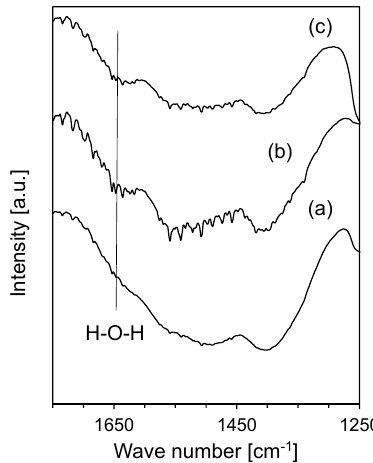
Figure 5. FTIR spectra of F04M catalyst coated with silica (a), zirconia (b), and titania (c).